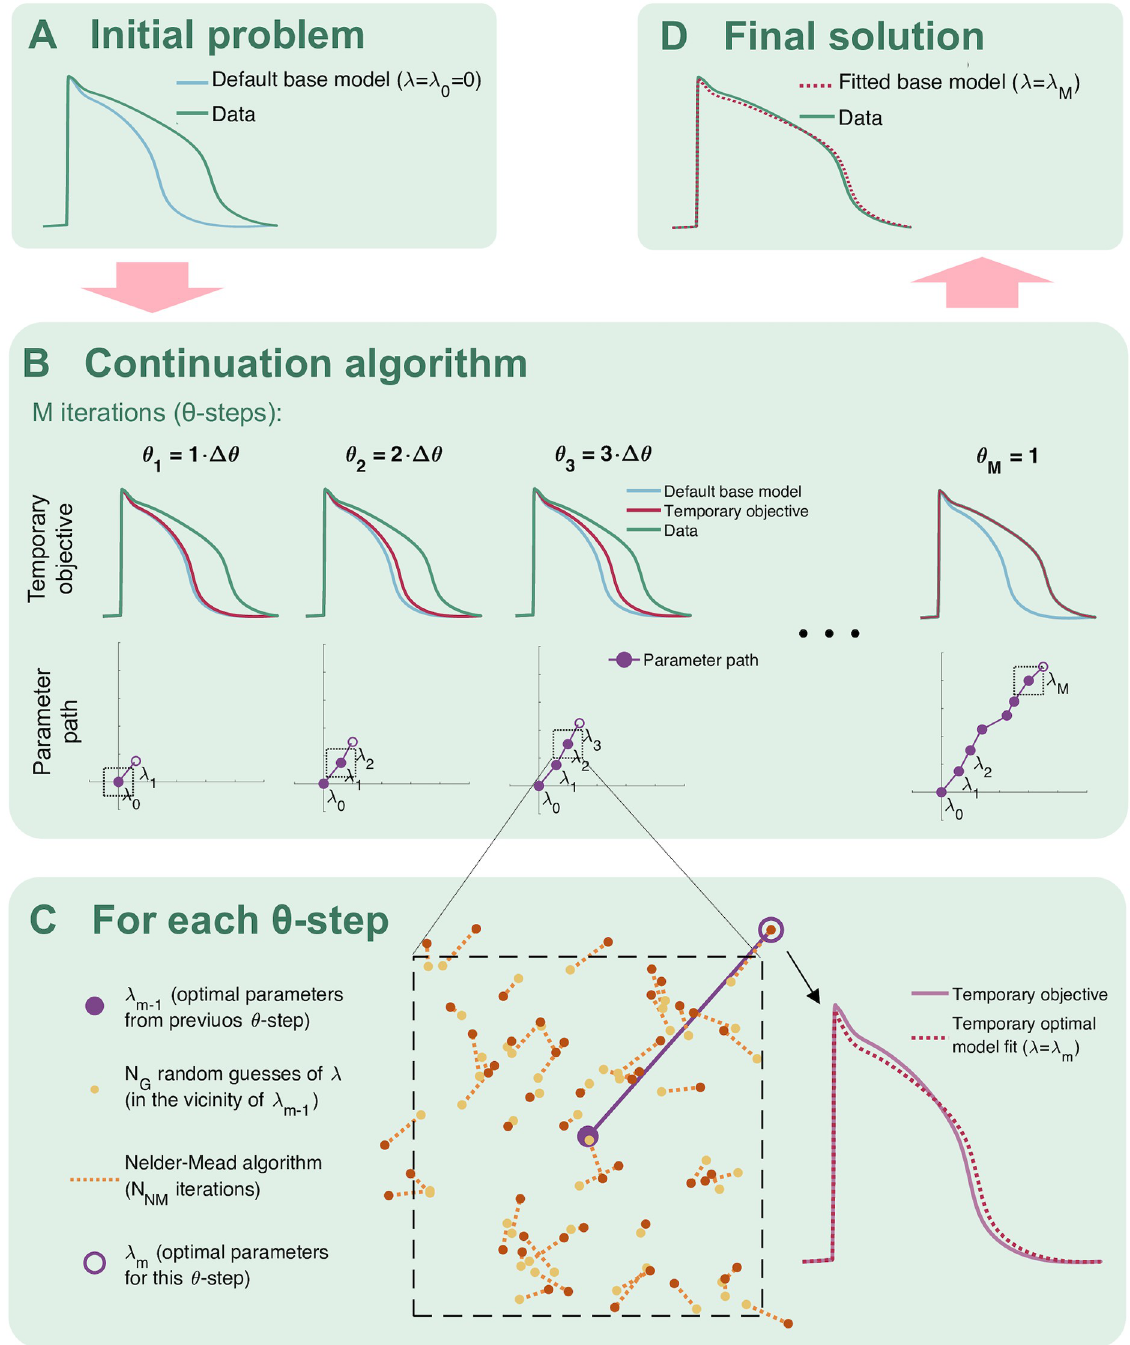
Fig 4. Illustration of the continuation algorithm used for optimization in the inversion method. A) The problem is defined by a default model and some data we are trying to invert by finding an optimal model parameterization fitting the data. B) In the continuation algorithm, we seek temporary optimal parameters in M iterations ( θ -steps). The objective for each θ -step is gradually changed from the default model to the data we are trying to invert. C) In each θ -step, we look for optimal parameters for the temporary objective by drawing N G random guesses in the vicinity of the optimal parameters from the previous θ -step. For each random guess, we run N NM Nelder-Mead iterations, and from the result, we select the best fit as the new optimal parameters. D) The final parameterization is given by the optimal parameters found in the last θ